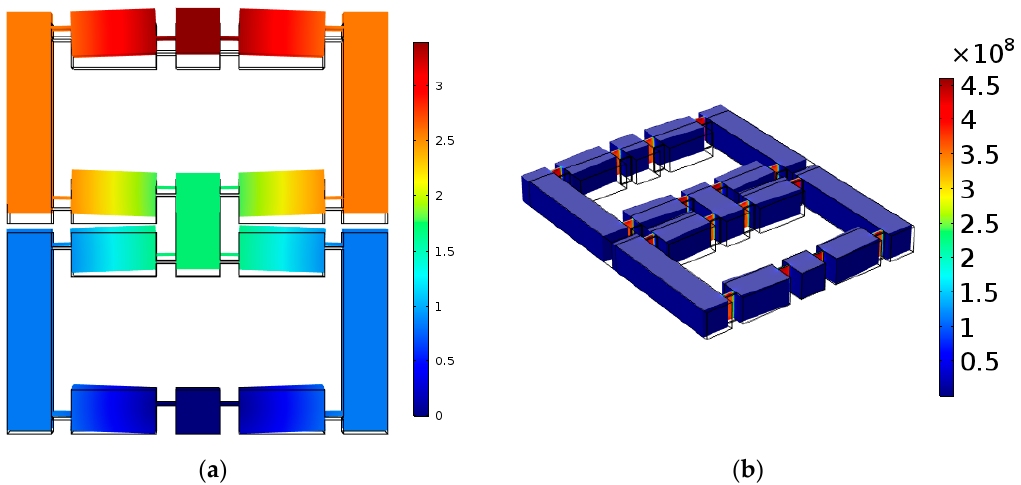
Figure 12. Static deformation simulation results in FEM software. ( a ) The deformation of DBMA, ( b ) The stress distribution of DBMA.